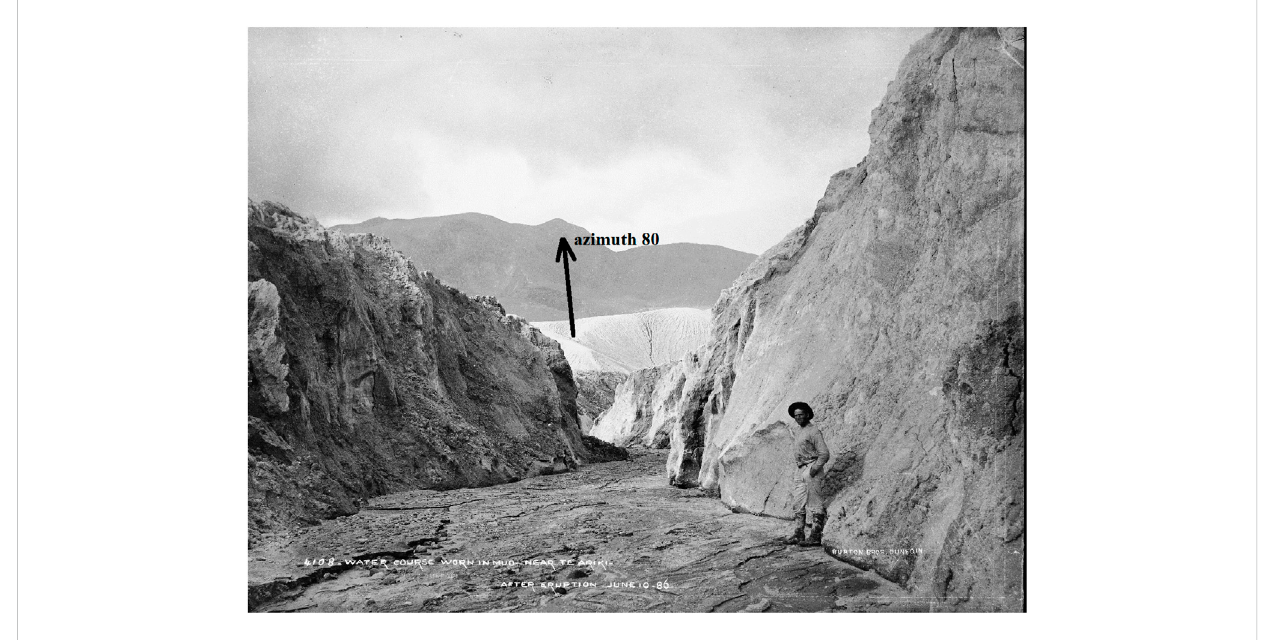
FIGURE 11 Kaiwaka Lower section, probably by Charles Spencer (1854 – 1933), for Burton Brothers, Dunedin, over 13 – 18/6/1886. The 80 ° azimuth is (approximately) on Koa Peak (MA_1043612 Te